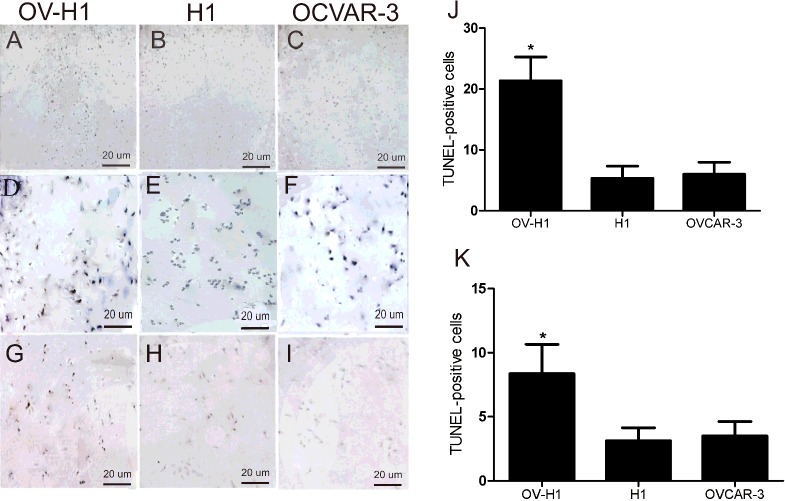
TUNEL apoptotic cell detection(A–I) The TUNEL in situ cell apoptosis detection results of the apoptosis signal of the OV-H1 hybrid cells, the of hESCs and OVCAR-3 ovarian cancer cells. (J–K) The number of positive cells.